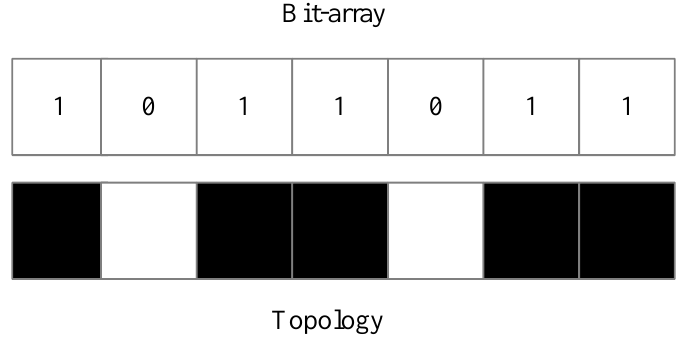
Figure 1. A 1D encoding bit-array and equivalent topology.